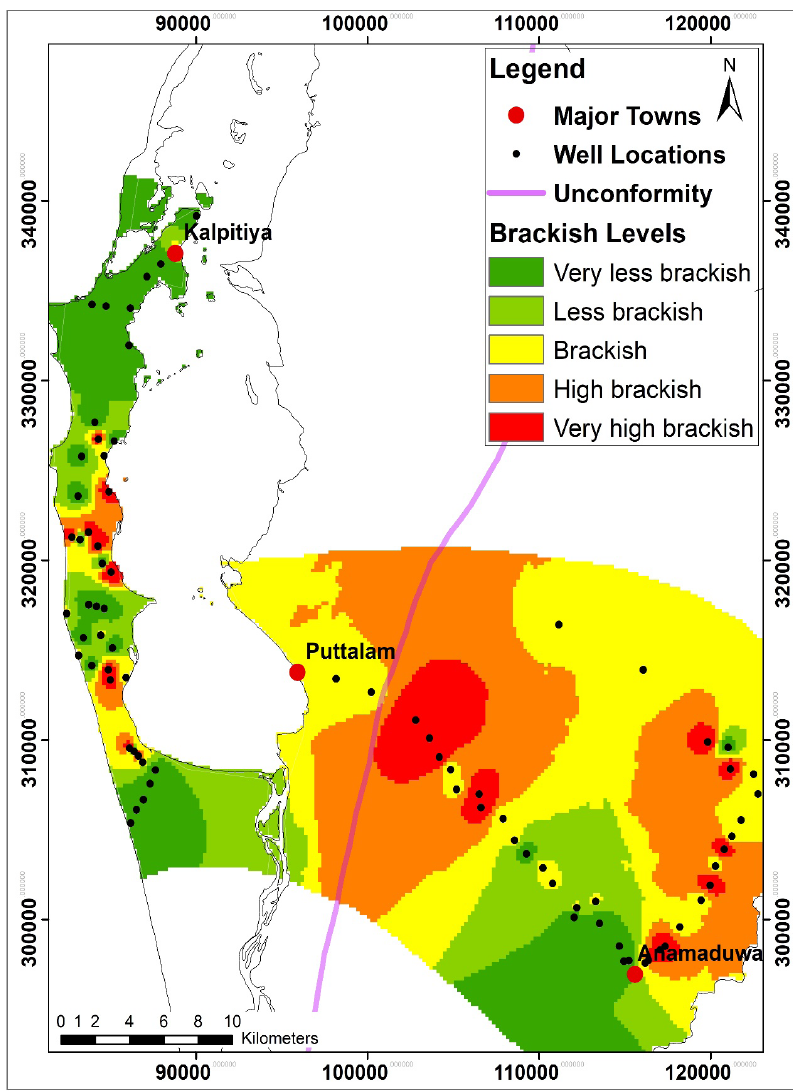
Figure 5: Kriged distribution of brackish condition in the study